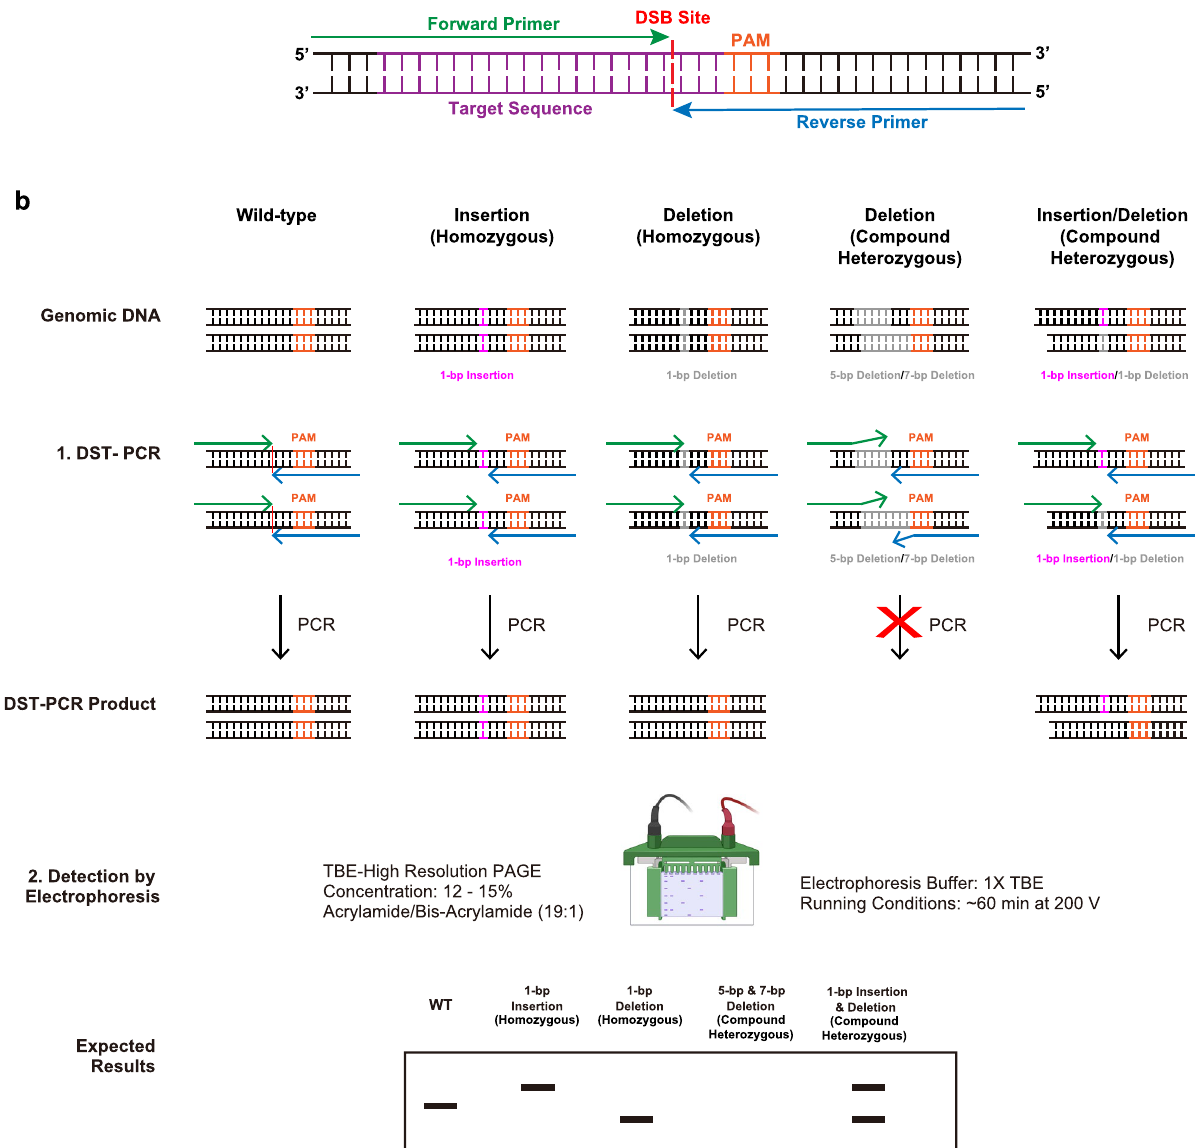
Figure 1. Overview of DST-PCR (DSB Site-Targeted PCR) ( a ) Principle of DST-PCR. Target sequences, PAM sequences, and double-strand break (DSB) are shown in magenta, orange, and red, respectively. Forward primer (green arrow) and reverse primer (blue arrow) face each other at the DSB site, i.e. between 3-bp and 4-bp upstream of the PAM sequence. ( b ) Overview of DST-PCR. 1. Principle of DST-PCR in distinguishing indels and wild-type sequences. Black lines represent genomic DNA from an allele of WT, 1-bp insertion (pink) mutant, and 1-bp deletion (grey) mutant. 2. Parameters for running TBE-PAGE and expected result of DST-PCR resolved by TBE-high-resolution-PAGE. Note that TBE-high-resolution-PAGE represents simplified pictures, it is possible that more than a single extra signal may be observed due to the nature of indels. Created in Adobe Illustrator CC V26.2.1 (https:// adobe. com/ produ cts/ illus trator) and adapted from “Protein Overexpression and Purification from Bacteria”, by BioRender.com (2020). Retrieved from https:// app. biore nder. com/ biore nder- templ